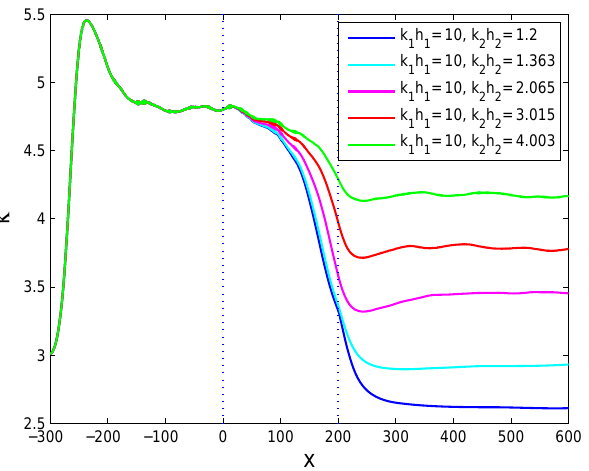
Fig. 10. Kurtosis as a function of x for k 1 h 1 = 10, k 2 h 2 = 1.2, 1.363, 2.065, 3.015, 4.003 and initial BFI = 0 . 5.